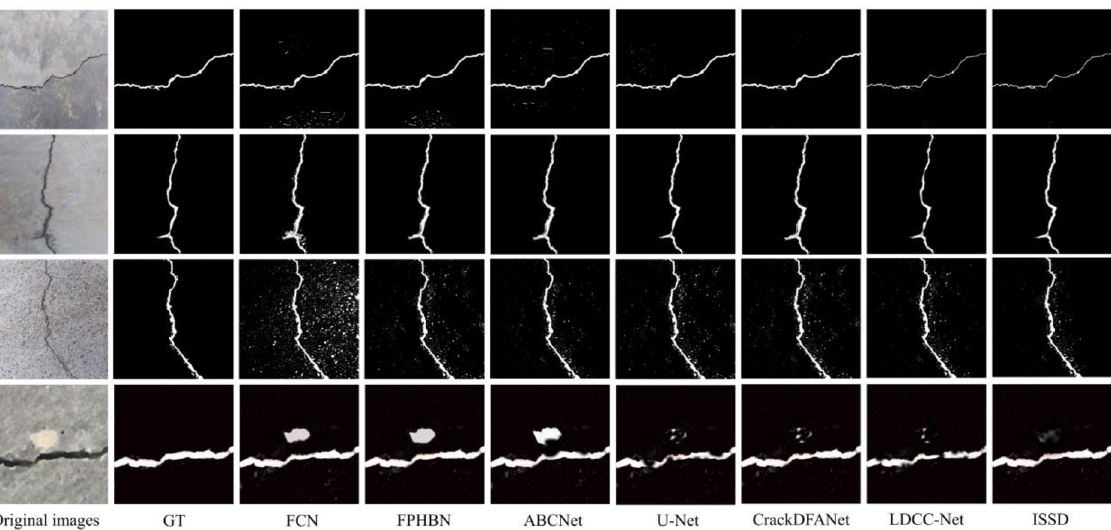
PLOS ONE | https://doi.org/10.1371/journal.pone.0275538 October 4,